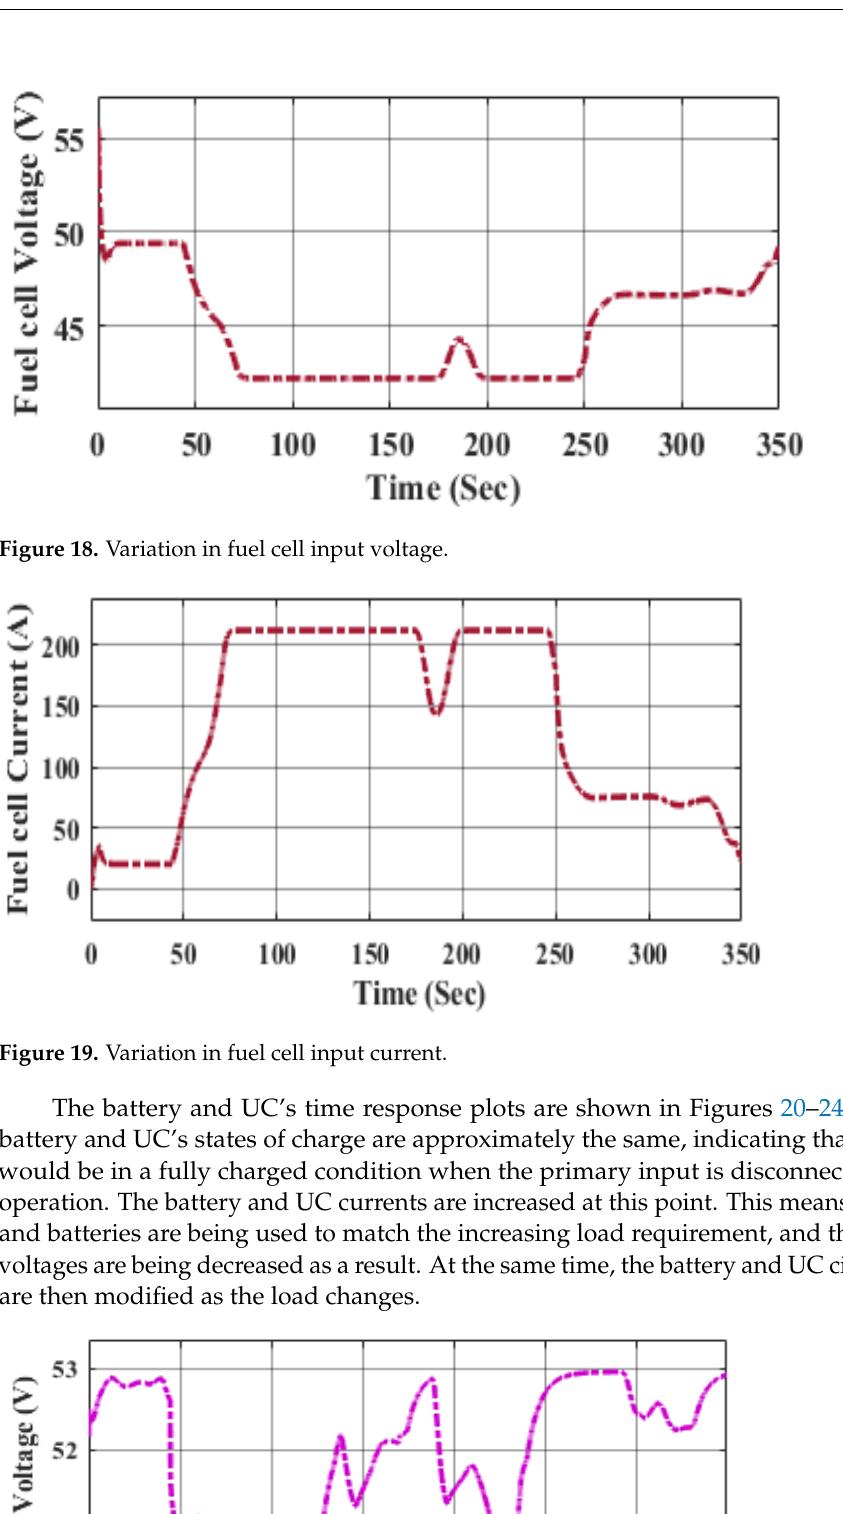
Figure 20. Battery voltage – time response.